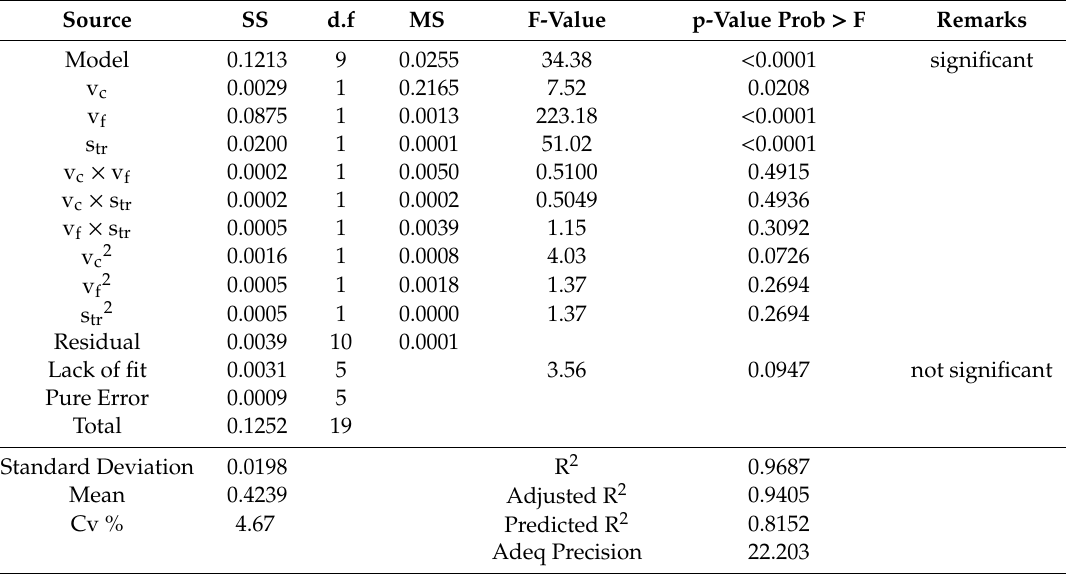
Table 5. Analysis of variance (ANOVA) table for surface